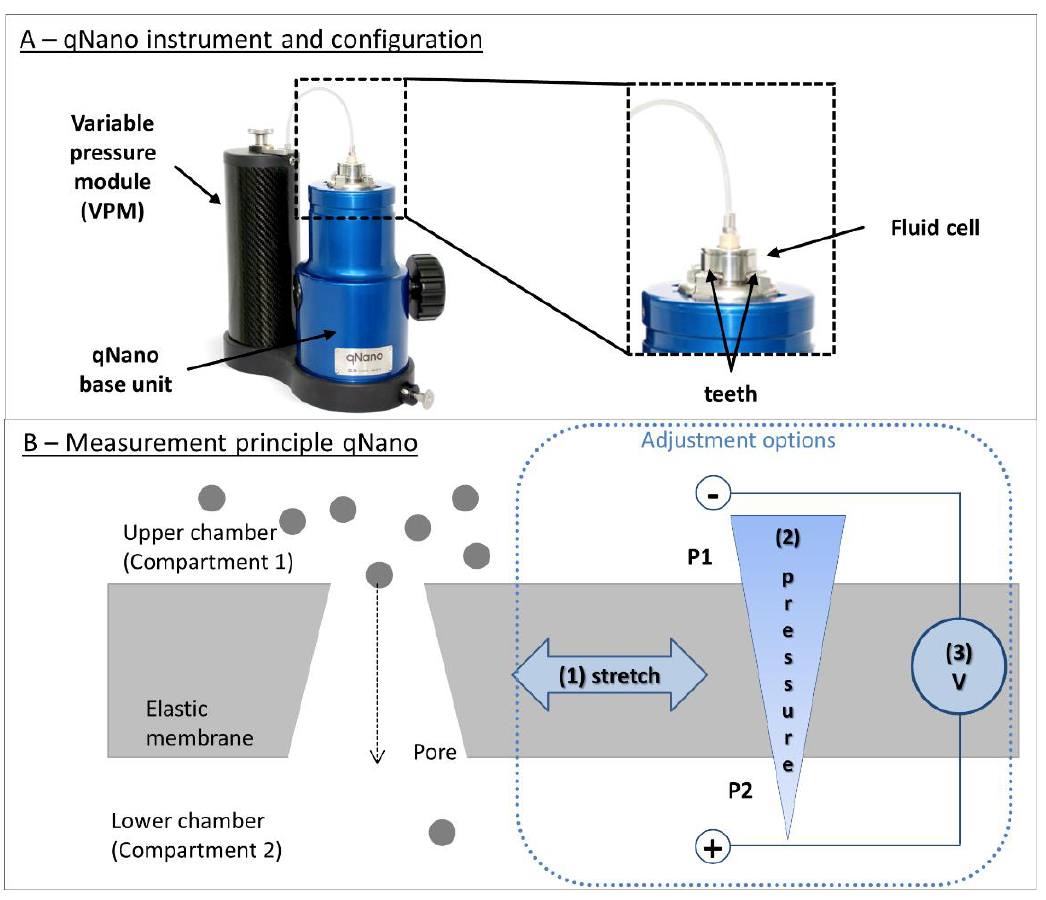
Figure 6. Tunable resistive pulse sensing technology (TRPS): instrument, specific pores, and measurement principle. ( A ) Configuration of the qNano instrument using the TRPS technology (Izon Science Ltd.) zooming from the complete device (left) to the specimen with the tunable nanopore (right). Image adapted with permission from a product of Izon Science Ltd., 2020. ( B ) Schematic illustration of the measurement principle of the qNano instrument. The suspended particles in the upper compartment pass through the pore and cause the resistive pulse. There are three options to adjust the instrument for optimal settings for the specific sample: mechanical pore stretching, pressure difference adjustment, and the applied direct current voltage (right).